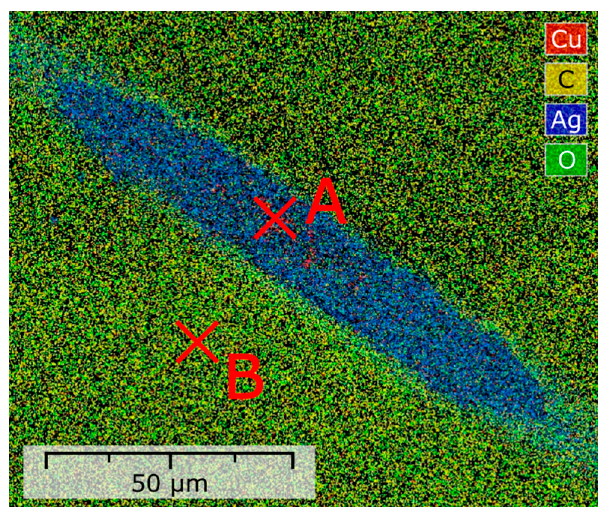
Figure 6. Composite element map in the area of single uncovered wire. C—yellow, O—green, Ag—blue, Cu—red (distance 0.35 mm, treatment time 1 s). Table 1. Concentration of Carbon, Oxygen, Silver and Copper on the sample after 1 s etching at distance 0.35 mm measured in the areas A and B as shown in Figure 6. Concentration (at.%) Element